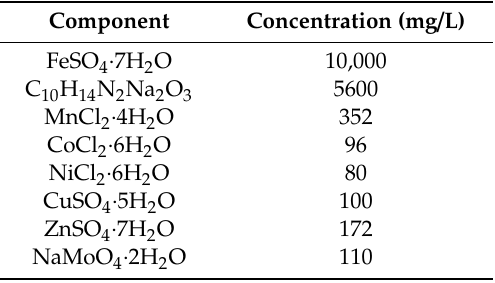
Table 2. Trace elements in the reactor